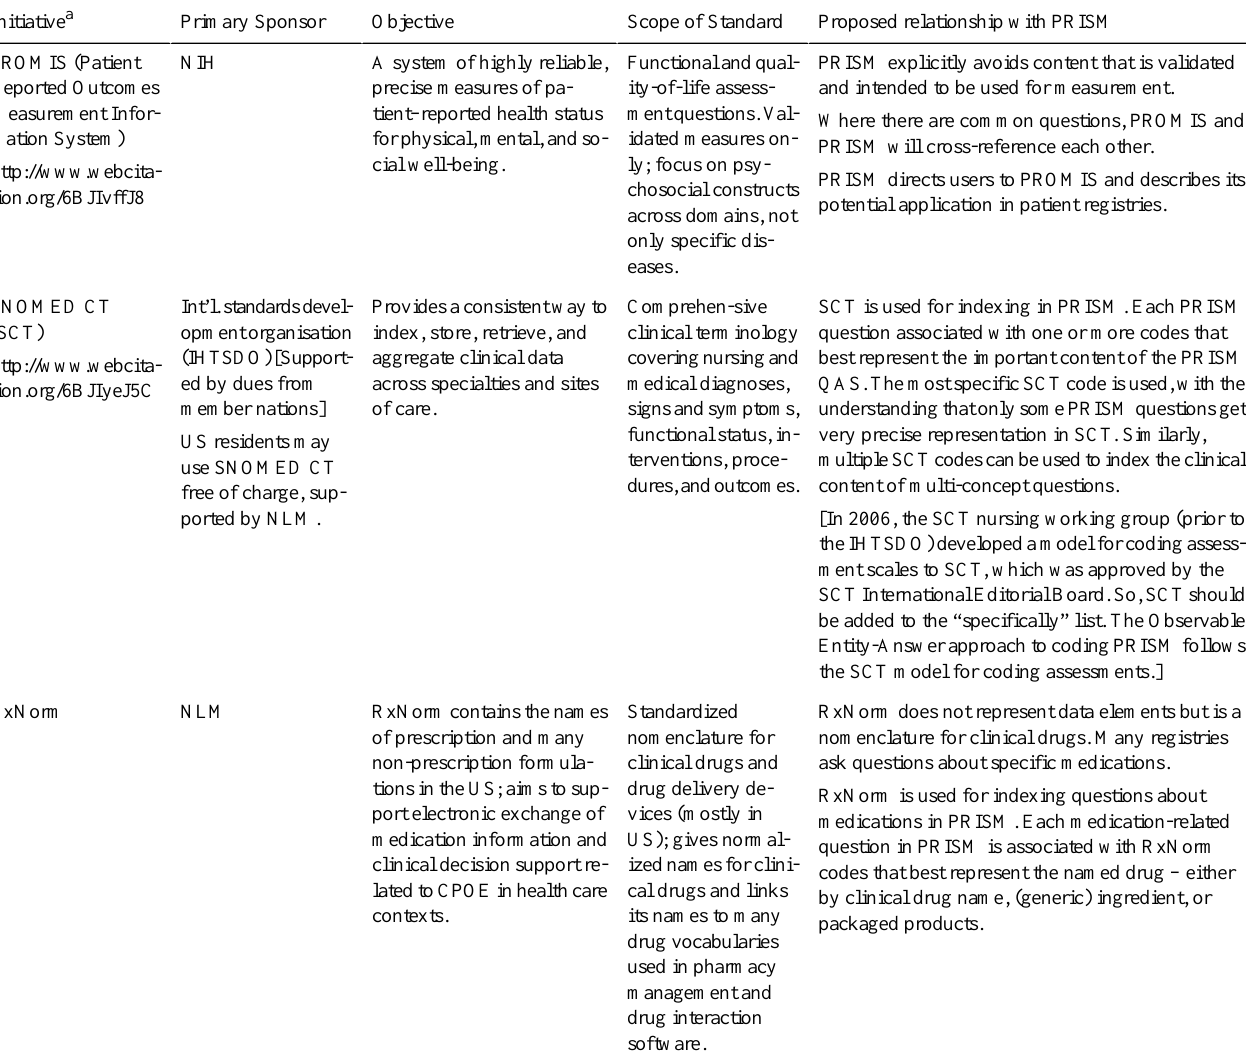
Table 2. Relationship of PRISM to Related Standards Efforts and Resources (PROMIS, SNOMED CT, RxNorm).